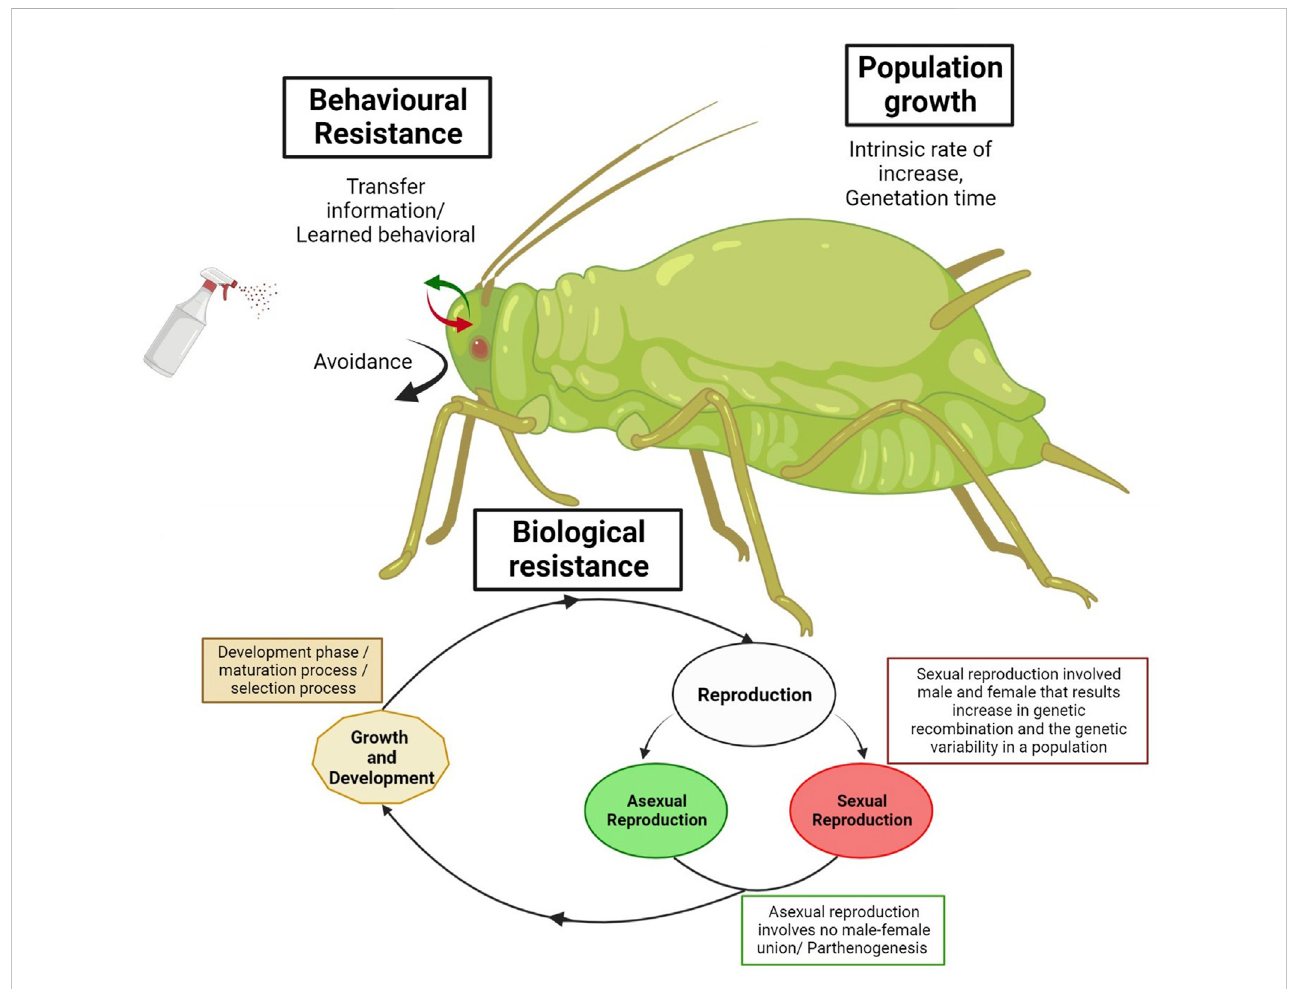
FIGURE 1 Schematic diagram of the biological and behavioral mechanisms of insecticide resistance in invasive